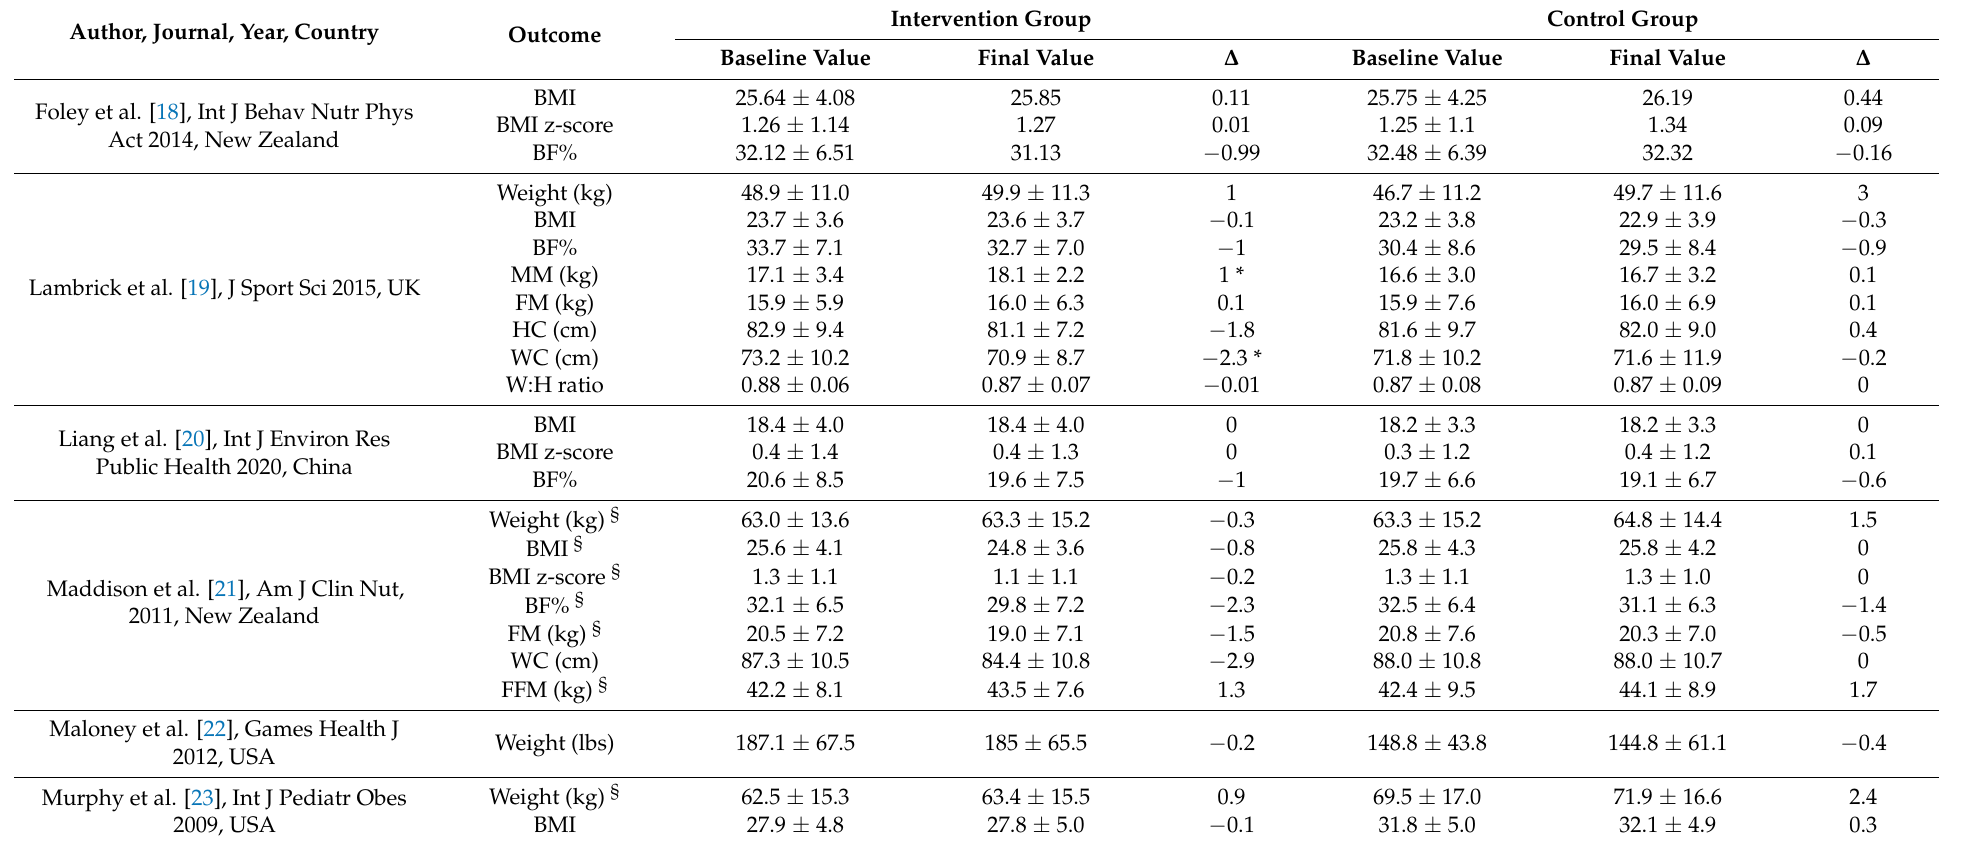
Table 2. Outcomes related to weight status reported for participants and controls by the selected